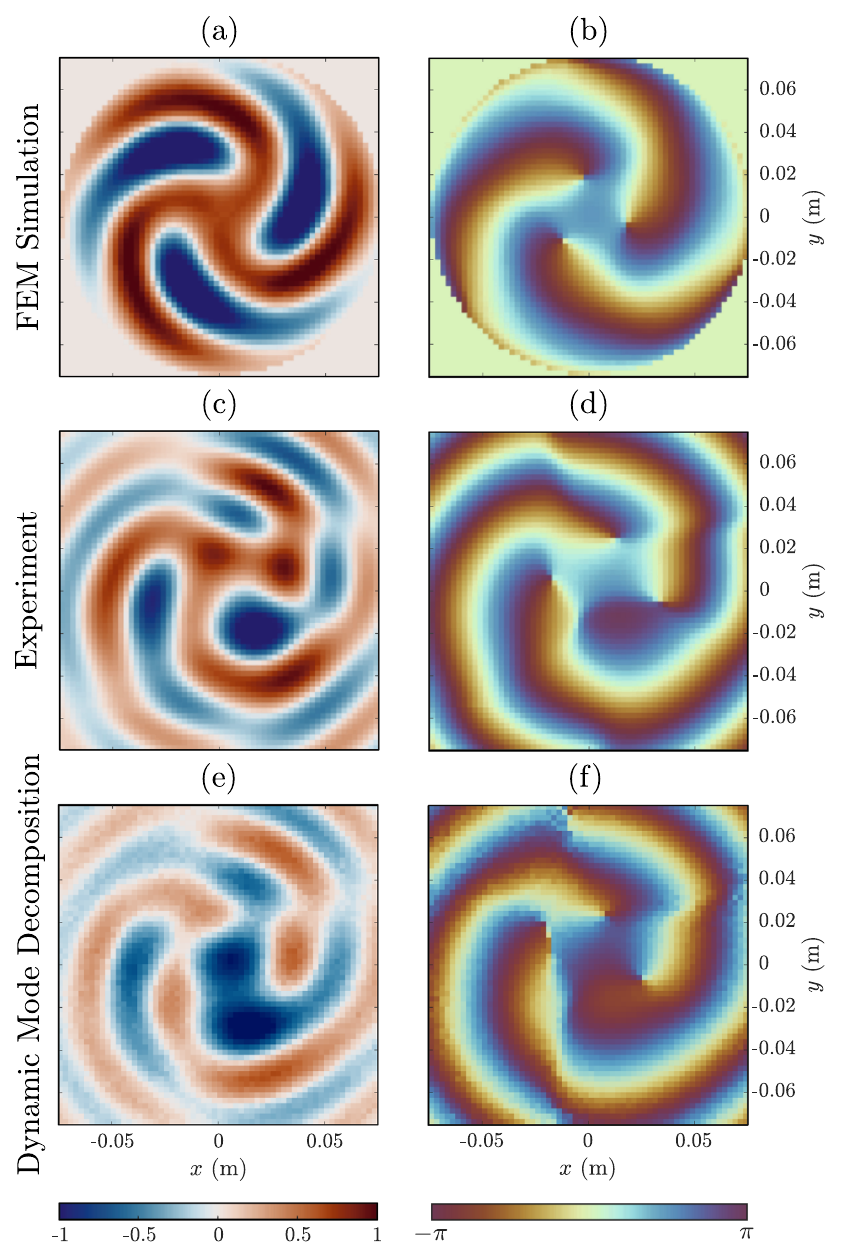
Fig. 2 Results and Comparisons. Frequency domain real pressure fi eld (left column) and phase (right column), at 58 kHz. The measurement plane is in the fl uid at a depth 20 mm from the submerged end of the pipe for a , b FEM Simulation, c , d Experiment and e , f Dynamic Mode Decomposition (performed on experimental data set — see Methods). A portion of the time domain experimental data is available in Supplementary Movie